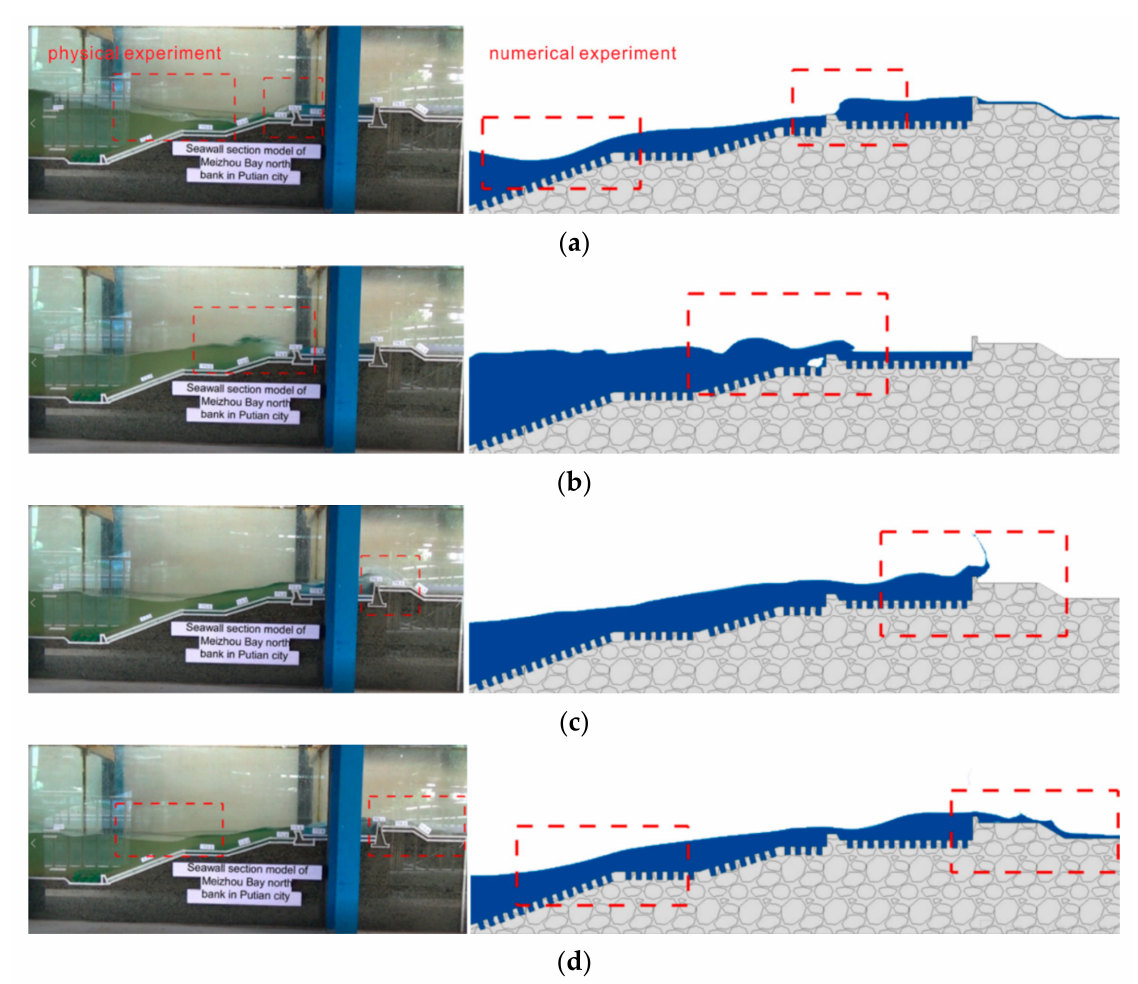
Figure 7. Comparison of flow field between the physical and numerical experiment; ( a ) wave run-up; ( b ) wave breaking; ( c ) wave overtopping; ( d ) water falling